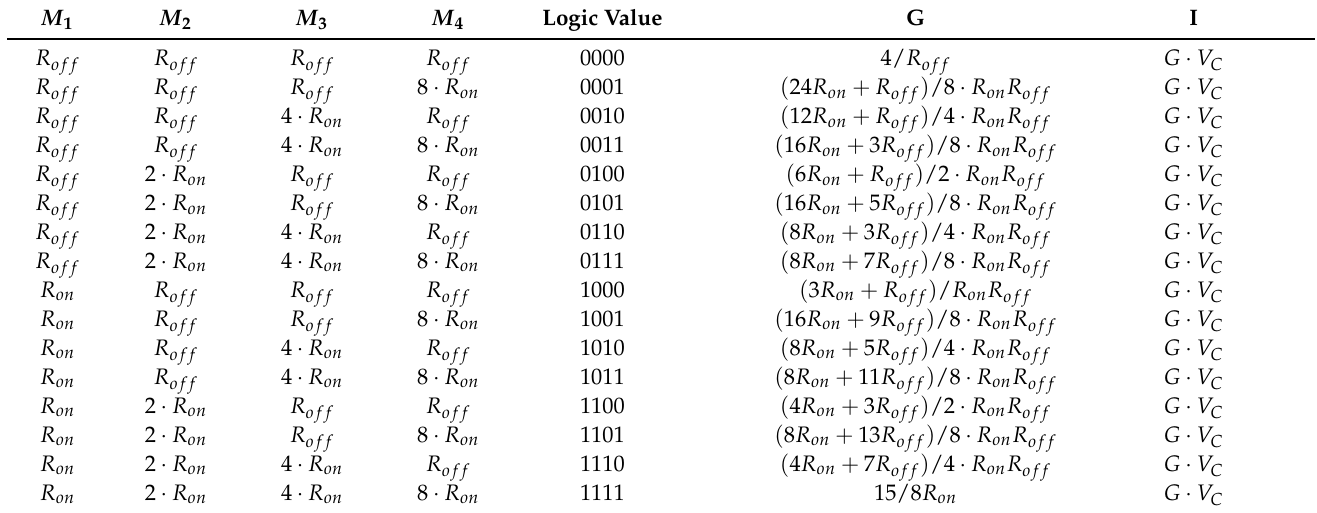
Table 3. The total conductivity value and the current value after pressurization of the memory